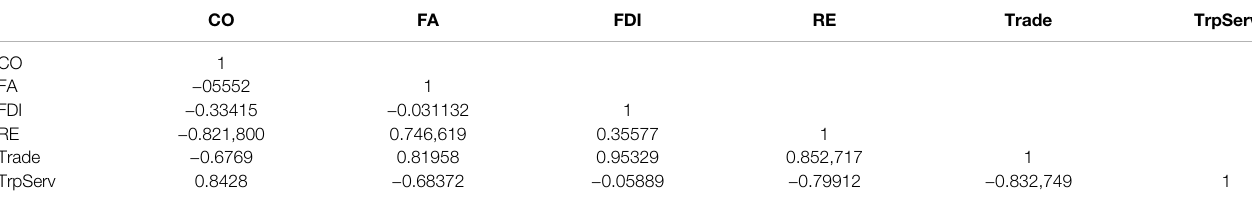
TABLE 3 | Correlation